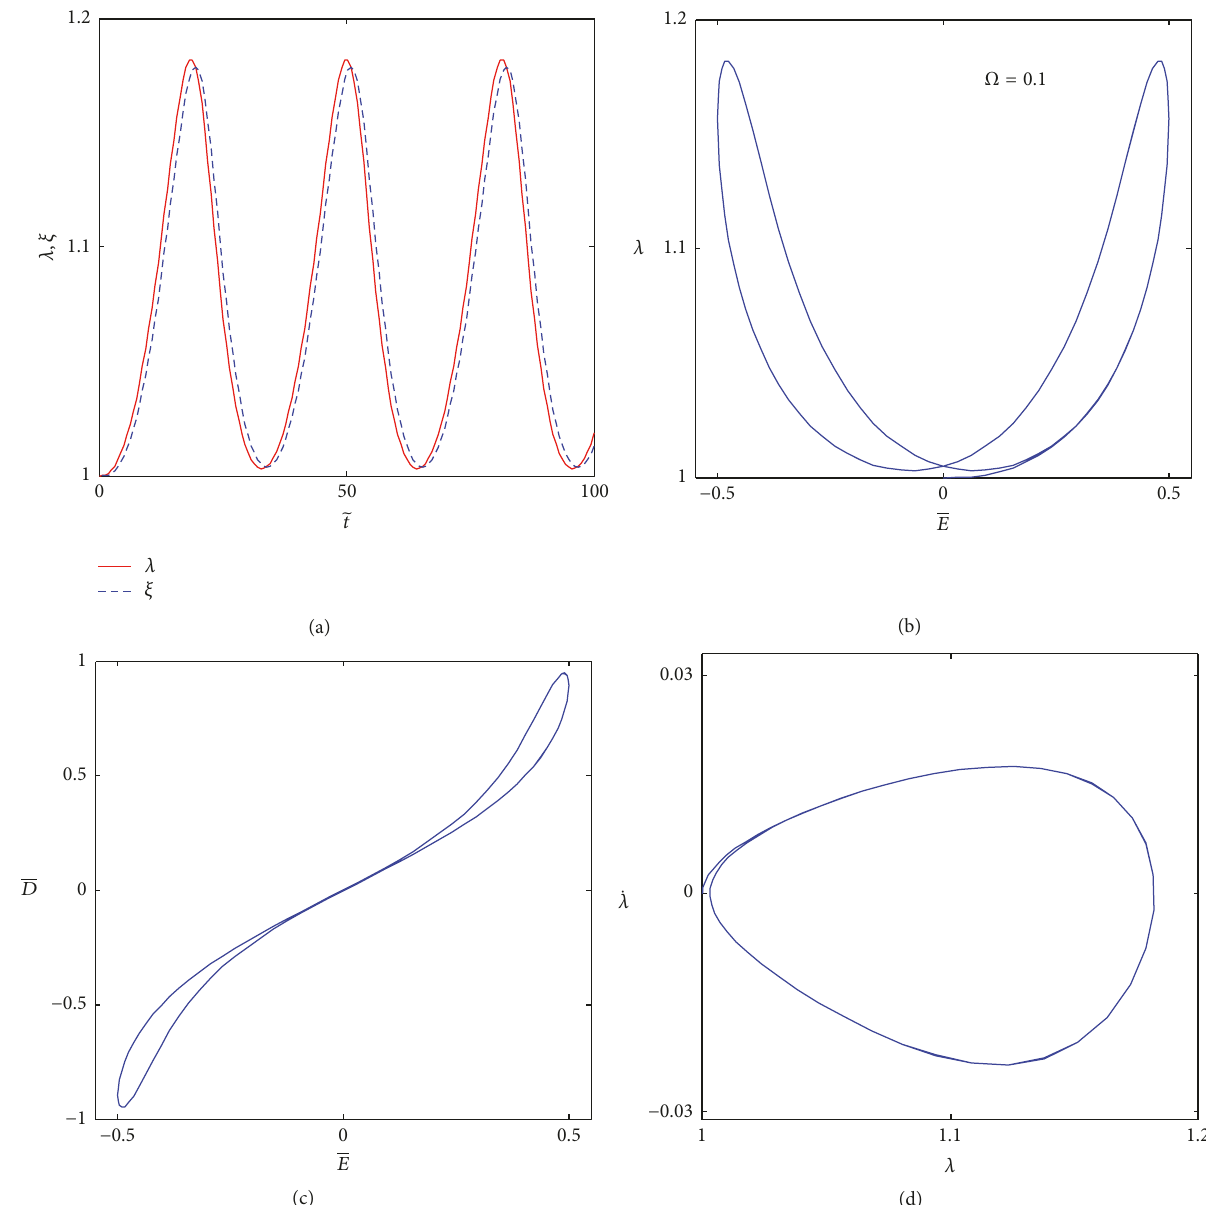
Figure 6: The total stretch 𝜆 , the viscous stretch 𝜉 (a), the nominal electric field-stretch response (b), the nominal electric field-nominal electric displacement (c), and the phase diagram (d) for the dimensionless frequency Ω = 0.1